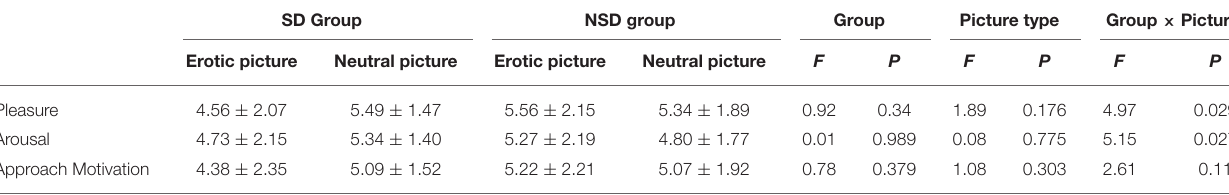
TABLE 5 | Response to erotic and neutral picture between sexual dysfunction and non-sexual dysfunction